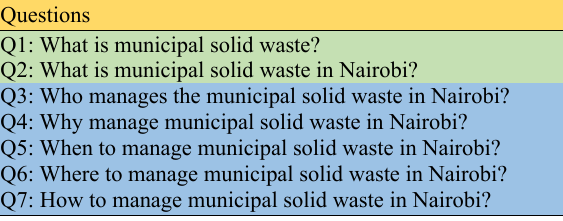
Table 3 . Questions to ask based on Figure